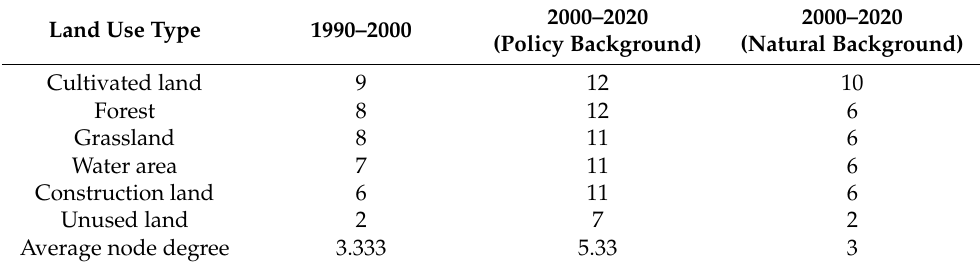
Table 8. Degree of land use type.